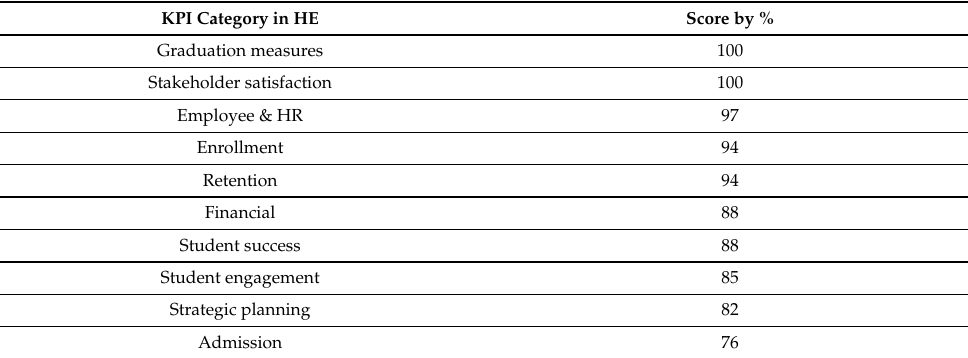
Table 5. The top 10 KPI categories ranked by critically by Ballard [40] (p.